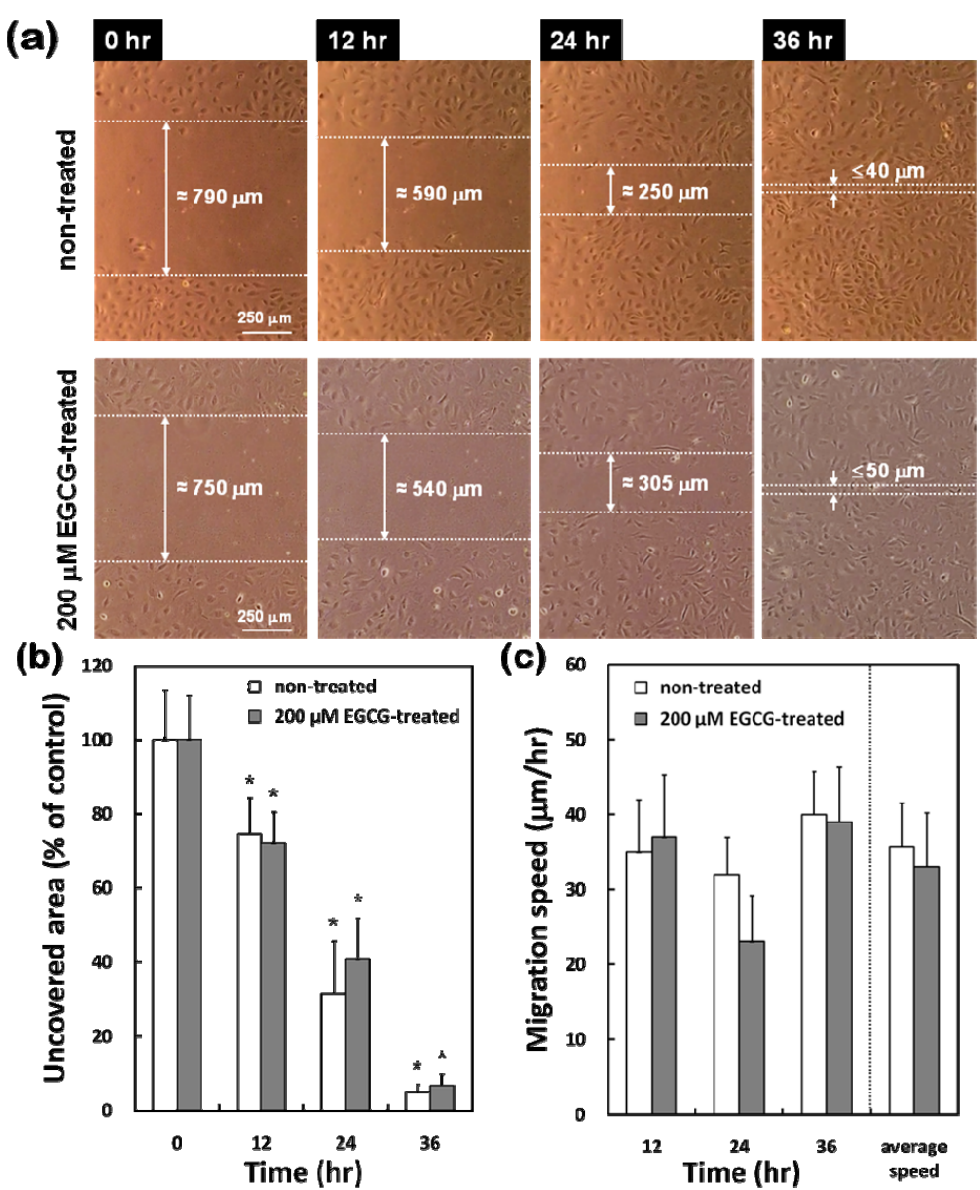
Figure 4. Effect of EGCG on migration of VECs. (a) Microscopic photographs (×40) of cells migrating into denuded areas (representative of six independent experiments,